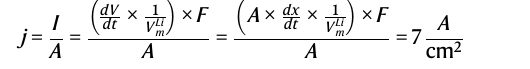
application this continuous lattice distortion causes a continuously increasing amount of pressure which, at some point, is released in form of ( e ) mechanical fracture. As a consequence, Li is plated along the new cracks ( f ) and drives the mechanical fracture even further until a short circuit is caused. g In case of short current pulses ( µ s) the time for the activation front buildup is shortenough to just cause a minor lattice distortion before the current is switched off again. h The accumulated Li-ions start to diffuse and distribute into the neighboring regions, hindering a signi fi cant pressure to arise. i Afterwards, the current is switched on again like in ( b ) and the process repeats